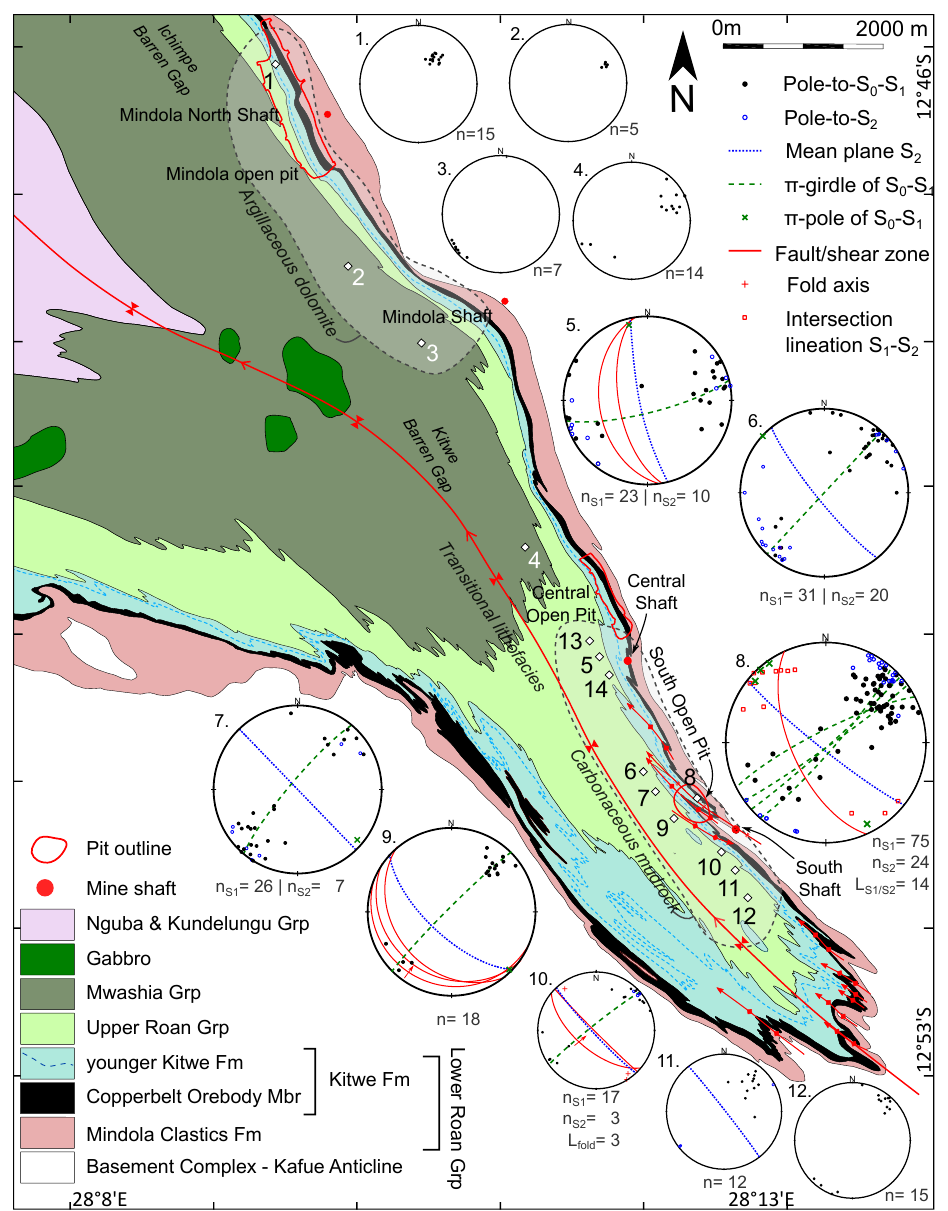
Figure 4. Regional structural analysis and lithological variations in the SE of the Chambishi–Nkana Basin. Geological map with indication of the location of mine shafts and open pits mentioned in this study (modified after Mopani Copper Mines Plc., 2009). The numbers indicate the mine sections that were studied in detail. Also indicated on the map is the spatial distribution of the different lithofacies within the COM. Lower-hemisphere equal-area stereoplots show orientation data in the measured sections. Data and statistics on S 1 and S 2 (including β girdles and π axes) are given in the